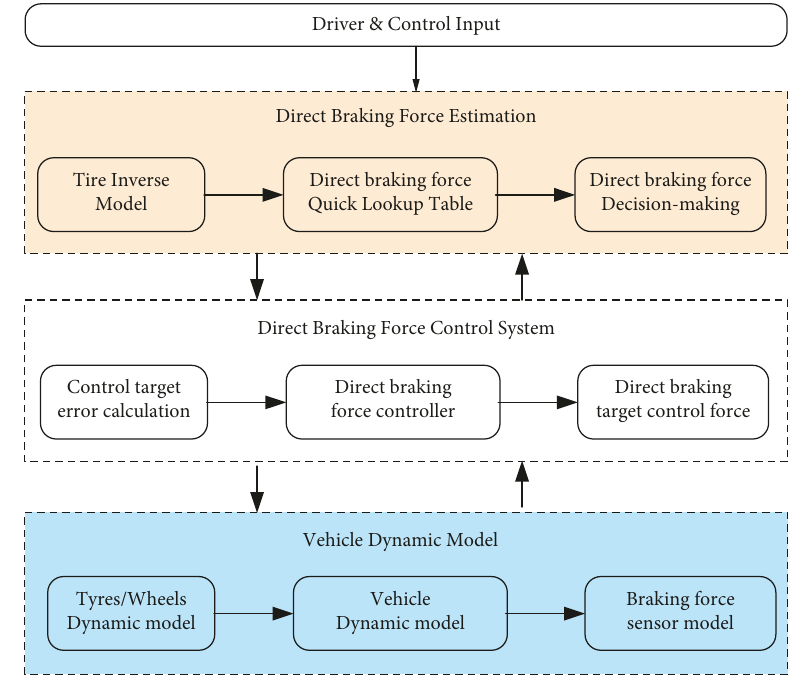
Figure 1: Schematic diagram of direct braking force estimation and control configuration.